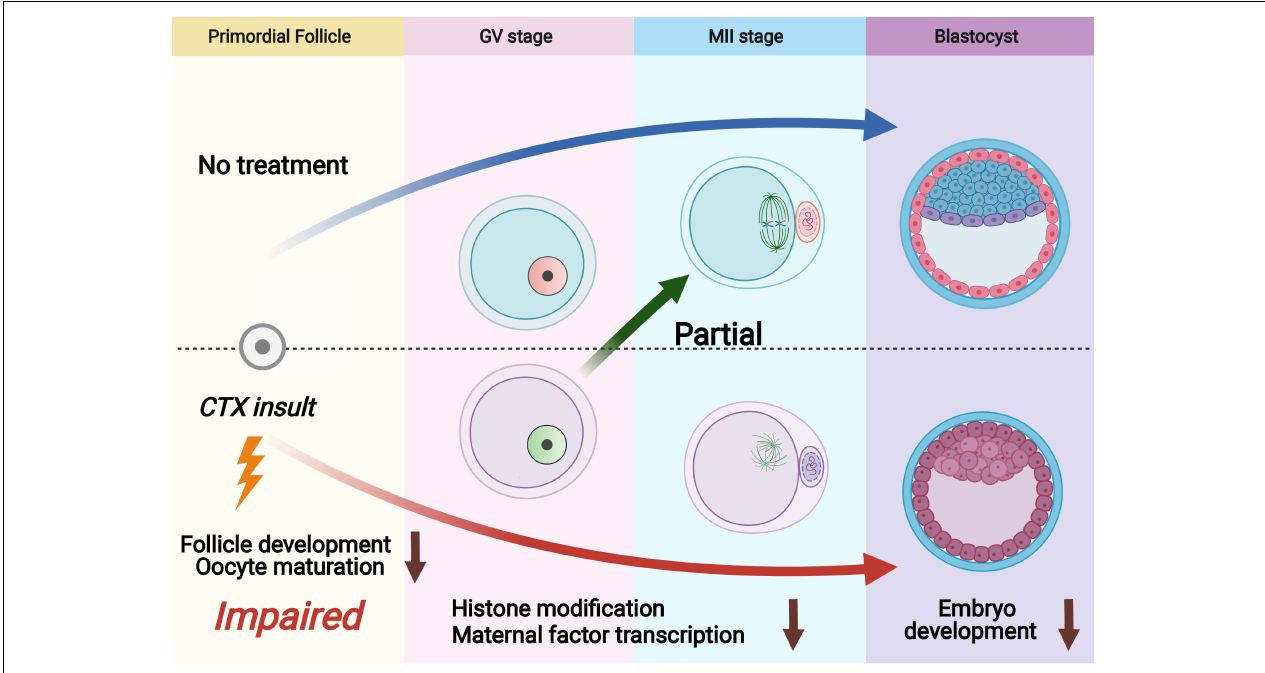
FIGURE 7 | Schematic diagram showing dysfunction of oocytes surviving from primordial follicles with pre-pubertal exposure to cyclophosphamide. Cyclophosphamide (CTX) causes overactivation of primordial follicles and induces DNA damage and eventually apoptosis as an acute toxic effect. A number of primordial follicles can survive chemotherapy and develop to the antral stage. The oocytes that survived CTX insult exhibited upregulation of H3K9me3, reduced H3K4me3 and low levels of 5hmC/5mC. Meanwhile, the maternal mRNAs were insufficiently accumulated after CTX insult, leading to low quality of mature oocyte (aneuploidy and mitochondrial dysfunction) and eventually affecting early embryo